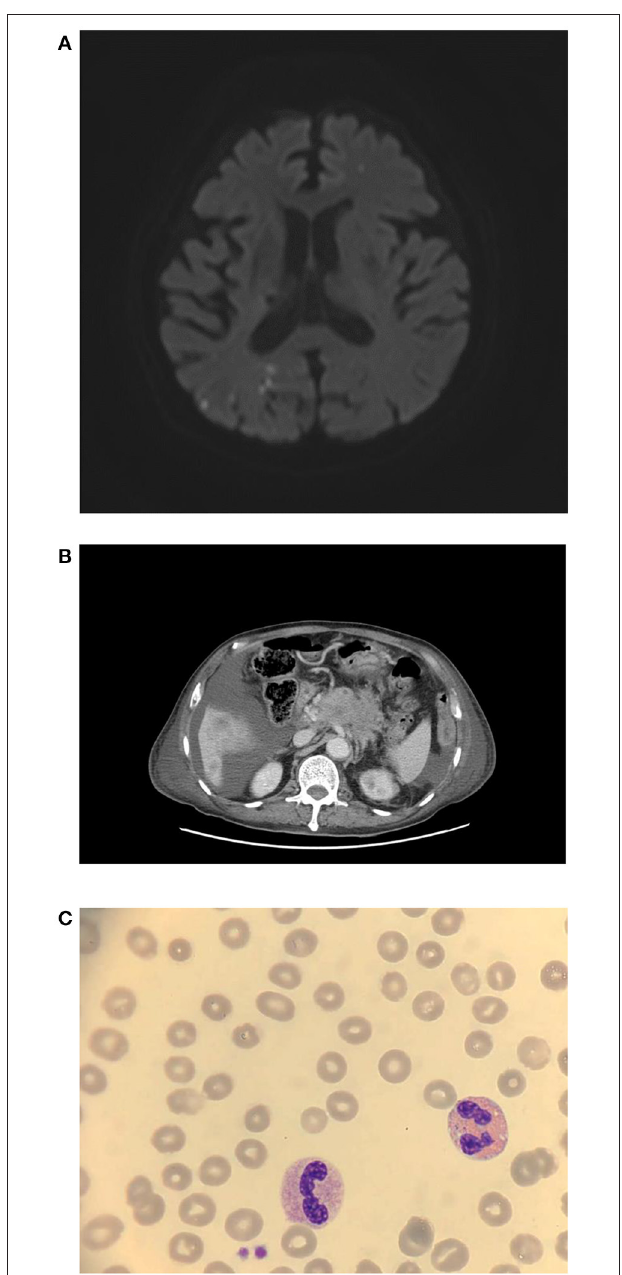
FIGURE 1 | (A) Brain MRA revealed diffuse right posterior cerebral territory infarction, 7 days after vaccination. (B) Accidentally, stage IV pancreatic cancer was found on abdominal CT. (C) Blood smear, 9 days after